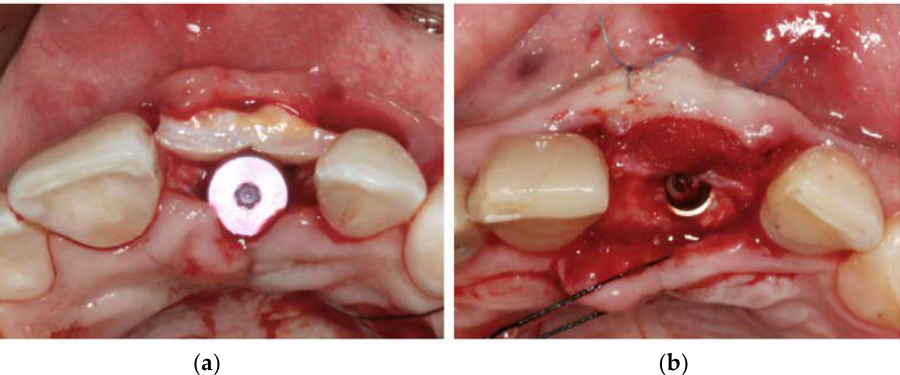
Figure 1. Clinical example of ( a ) connective tissue graft and ( b ) cross-linked porcine-derived col- lagen matrix.